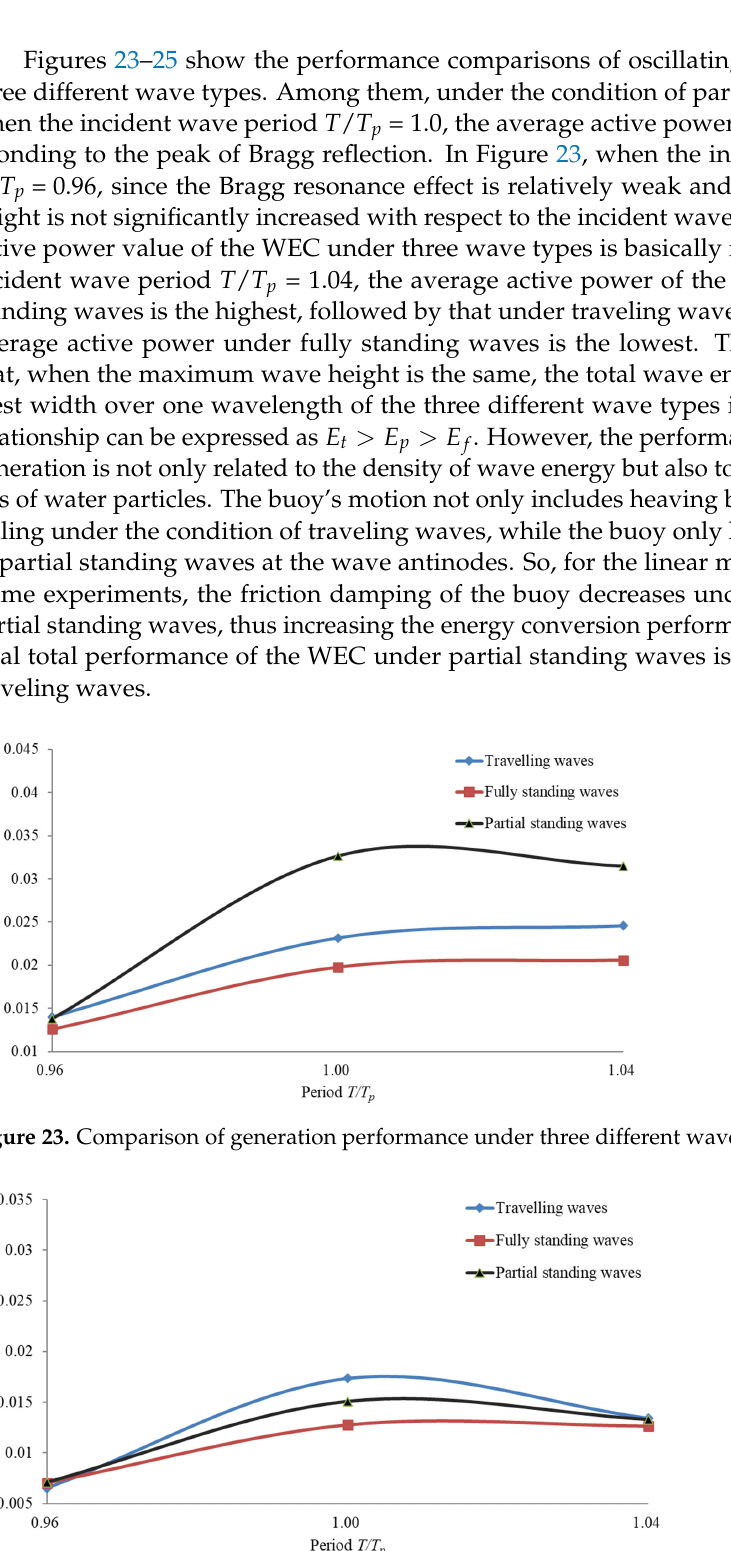
Figure 25. Comparison of generation performance under three different wave types at h = 0.8 m.